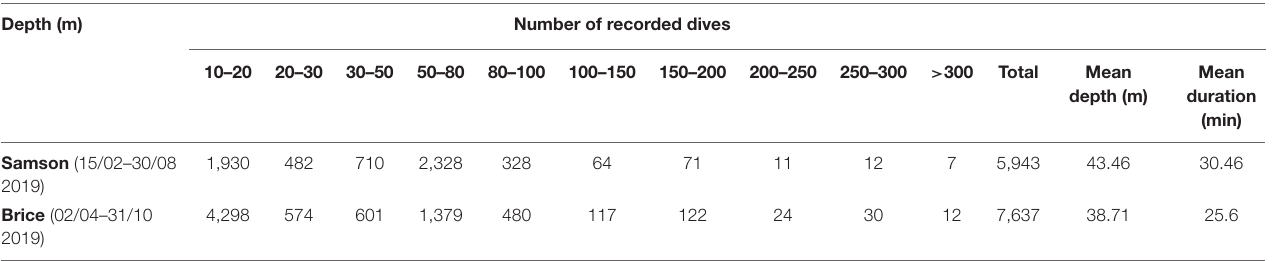
TABLE A1 | Diving behavior of sea turtles SAMSON and BRICE. Number of recorded dives > 10 m classified by depth layers. Depth